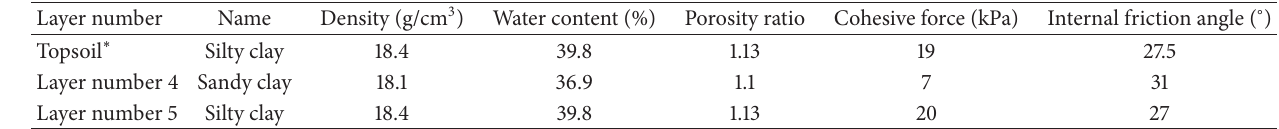
Table 1: The properties of the soil samples.